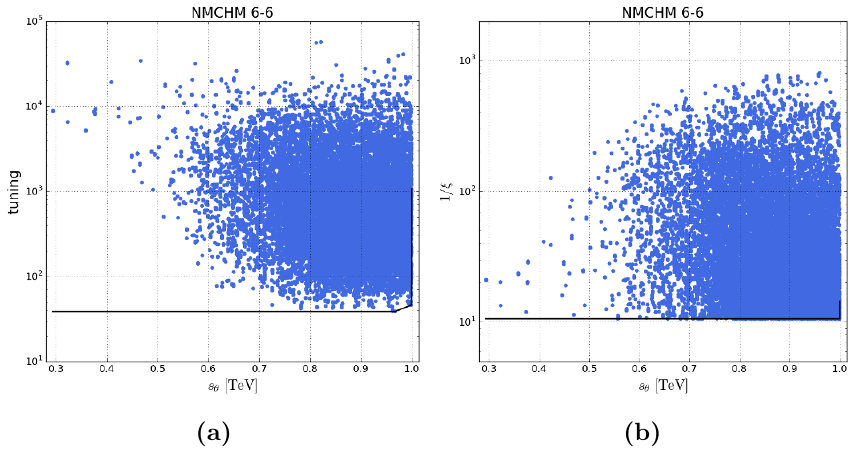
Figure 12. The top quark mixing parameter sin (cid:18) vs (top row left) higher order tuning and (top row right) naive tuning.